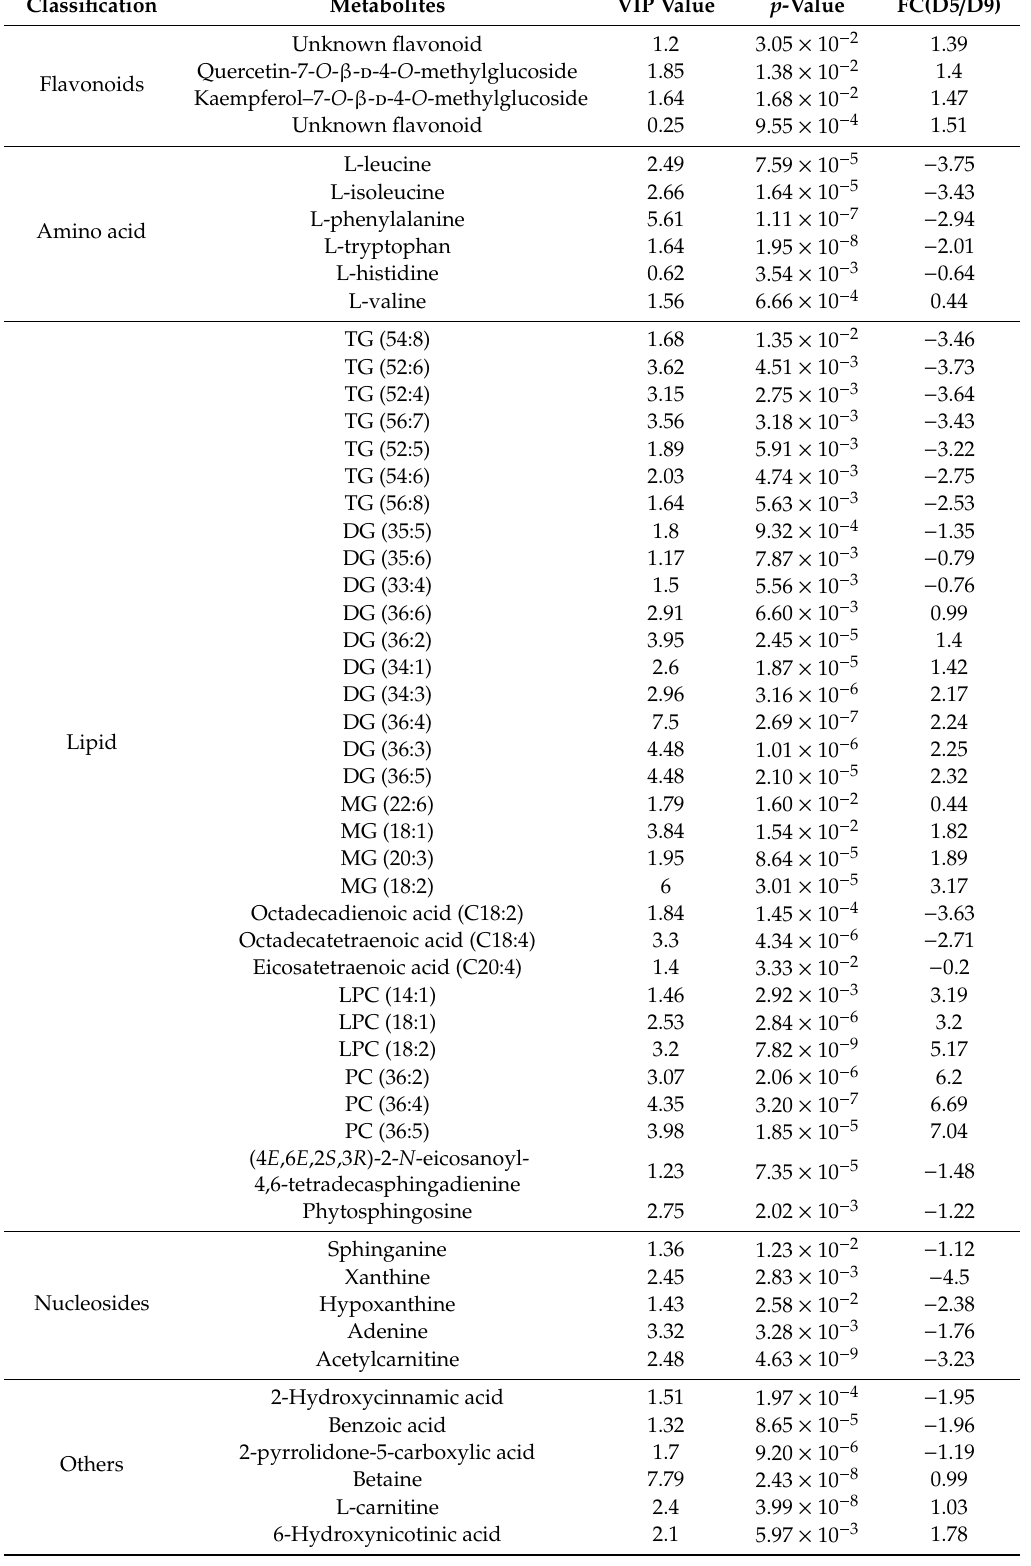
Table 4. Di ff erential metabolites between groups (D5 vs.